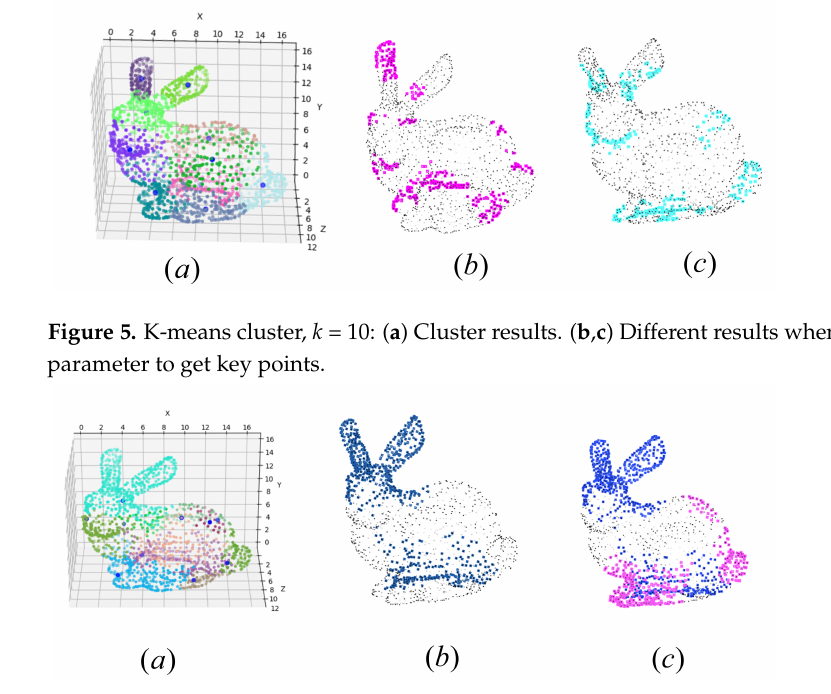
Figure 6. Curvature shift cluster, bandwidth = 1.2: ( a ) Cluster results. ( b ) Key points when (cid:101) = 0.8. ( c ) Key points when (cid:101) =